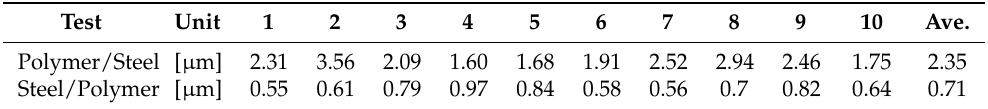
Table 4. Details of the gaps between the metal and